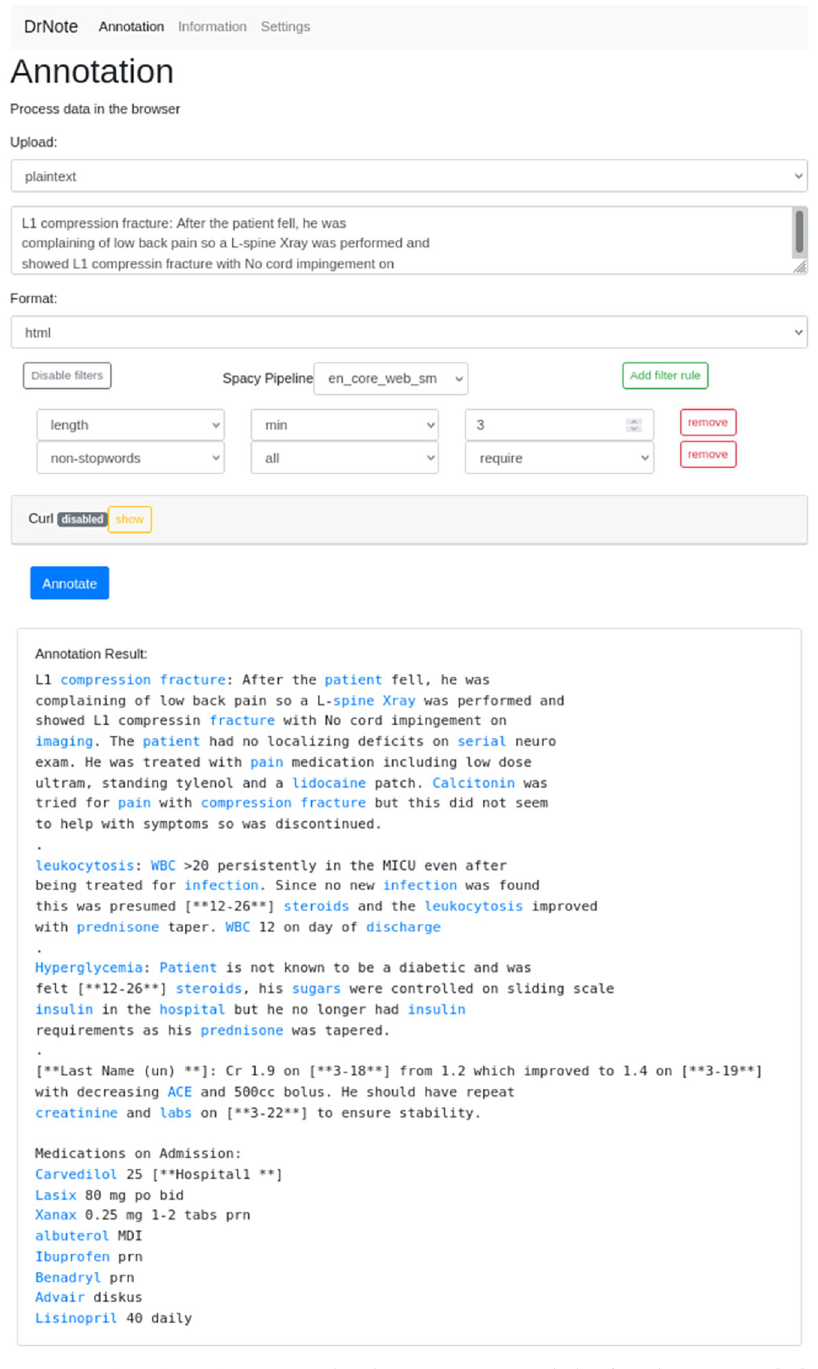
Fig 2. Demo for web interface. Browser-based annotation on example data from the MIMIC-III [49]